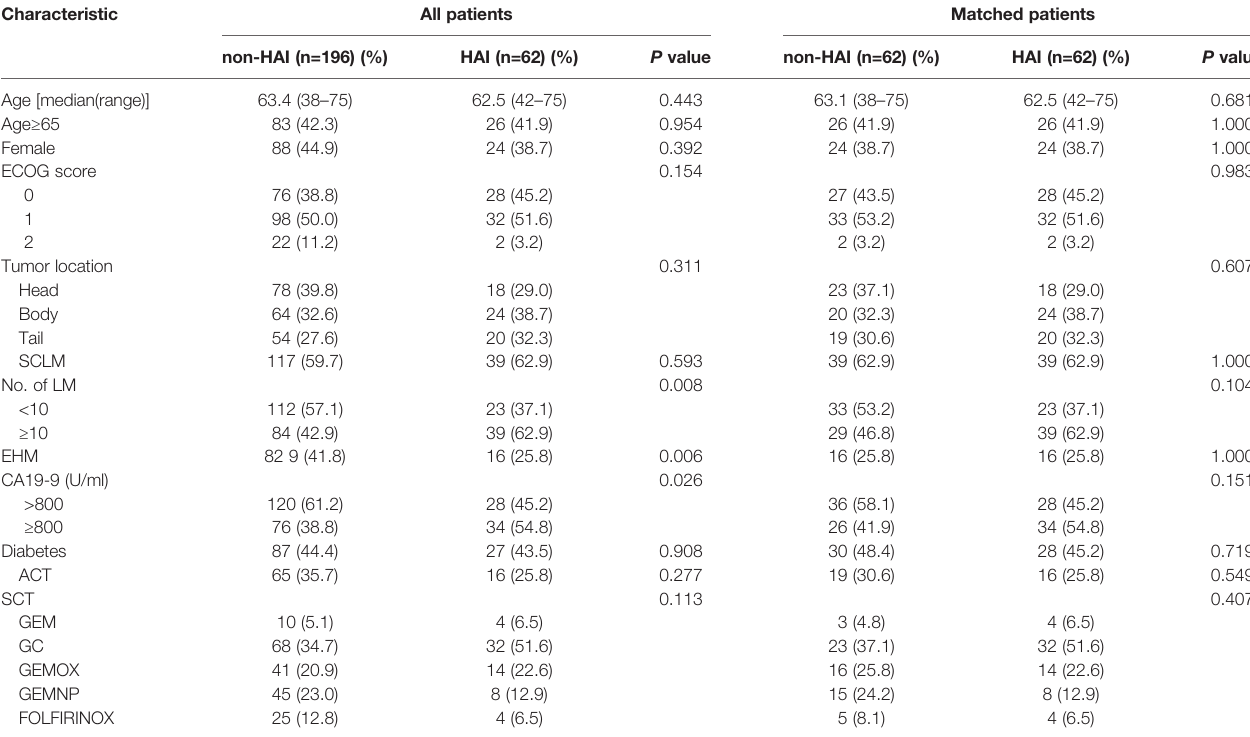
TABLE 1 | Baseline clinical